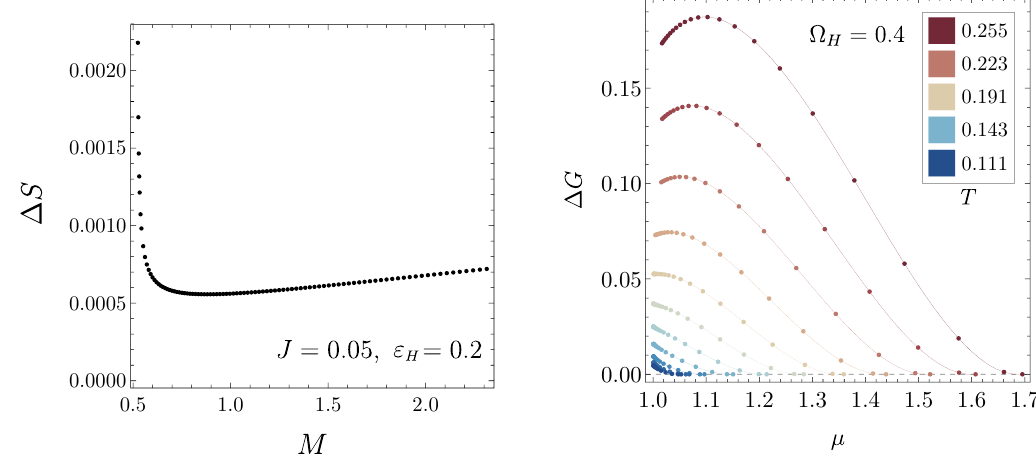
Figure 16 . Left : the entropy di(cid:11)erence (cid:1) S = S (cid:0) S CLP against the mass M , for black holes with (cid:12)xed J = 0 : 05 and " H = 0 : 2 (black data points), where S CLP is the entropy of the CLP black hole with the same charge Q and angular momentum J . Right : the di(cid:11)erence in Gibbs free energy (cid:1) G = G (cid:0) G CLP , where G CLP is the free energy for the corresponding CLP solution with the same temperature T , and thermodynamic angular velocity (cid:10) H . We (cid:12)nd that for all hairy solutions have G < 0, hence at (cid:12)xed chemical potential (cid:22) , (cid:1) G > 0 indicates that the phase without hair dominates the